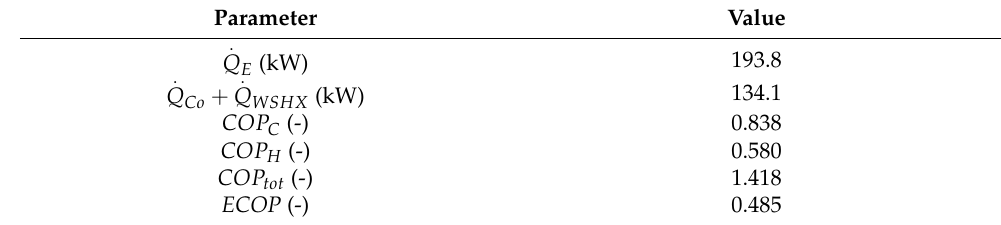
Figure 17. ECOP achieved for each application.